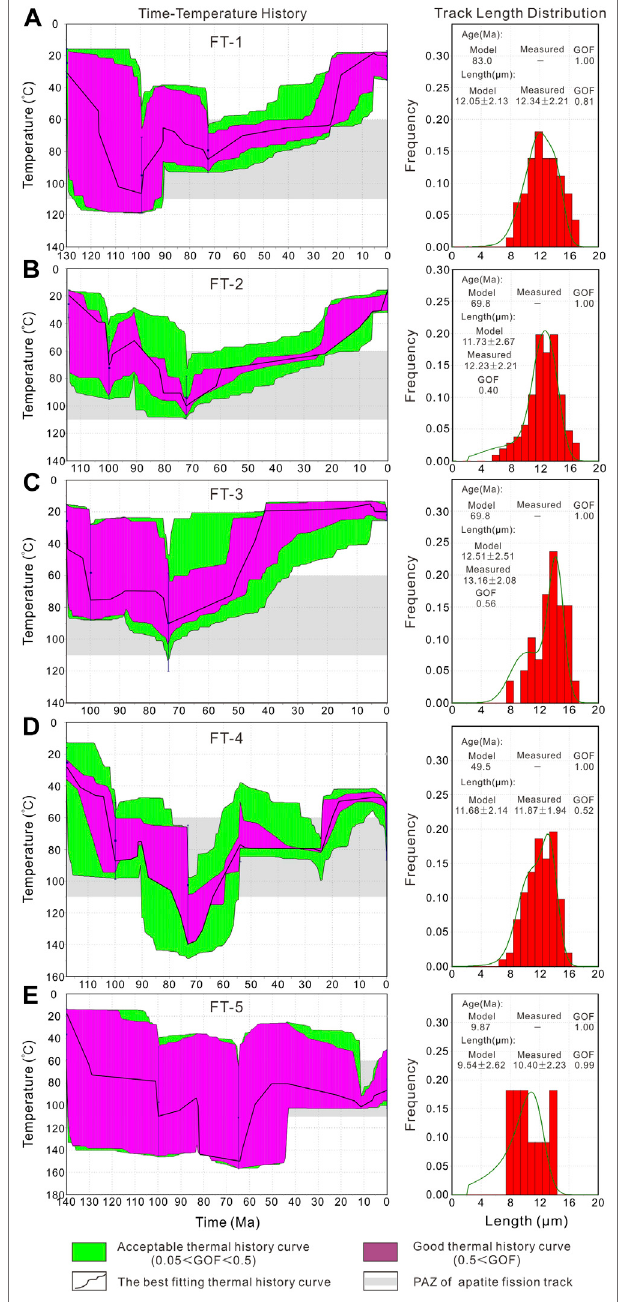
FIGURE 6 | Simulation results of time-temperature history in the Dasanjiang area. In the left picture, the green line indicates the acceptable thermal history path, the pink line indicates the good thermal history path, the black line indicates the optimal thermal history path, the blue line indicates the constraints of thermal history modeling, and the gray box indicates the annealing of apatite belt. In the right picture, the red column indicates the con fi ned fi ssion track length distribution of the apatite and the green line indicates the result of the fi tting.